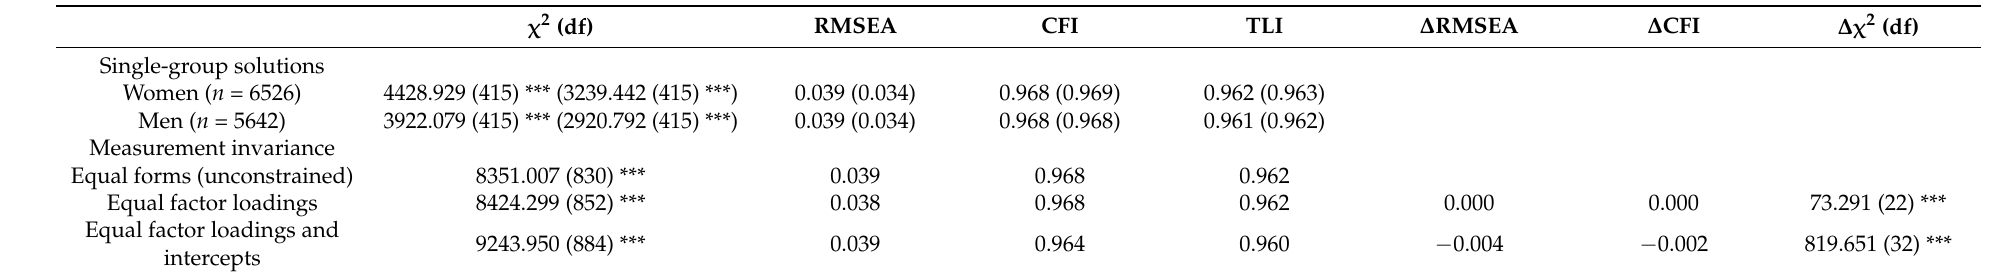
Table 2. Tests of factorial invariance of the measurement model across genders ( n =